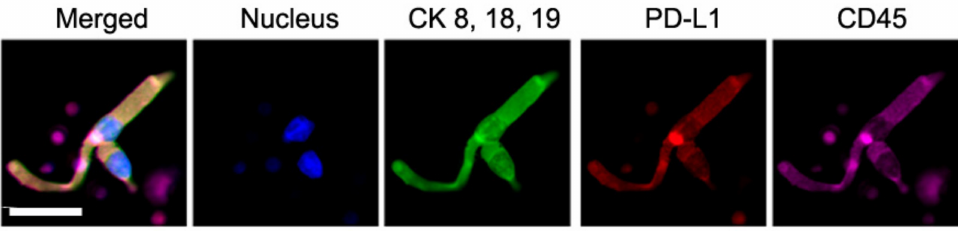
Figure 11. Image of two CAMLs next to each other. CAMLs were stained for CK8, 18, 19, PD-L1, and CD45, which appeared in the cytoplasm. The scale bar is 50 µ m.